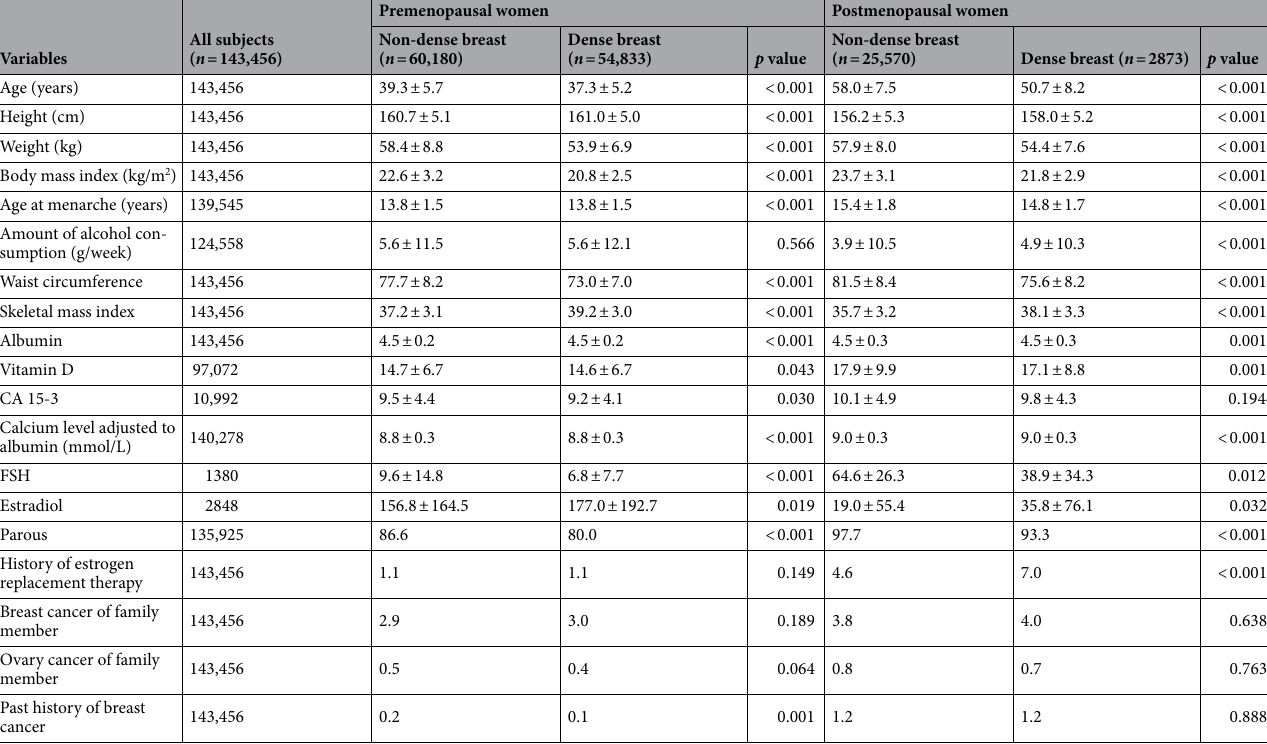
Table 1. Characteristics and anthropometric measurements of participants by menopausal status and mammographic density. Data are presented as mean ± standard deviation or